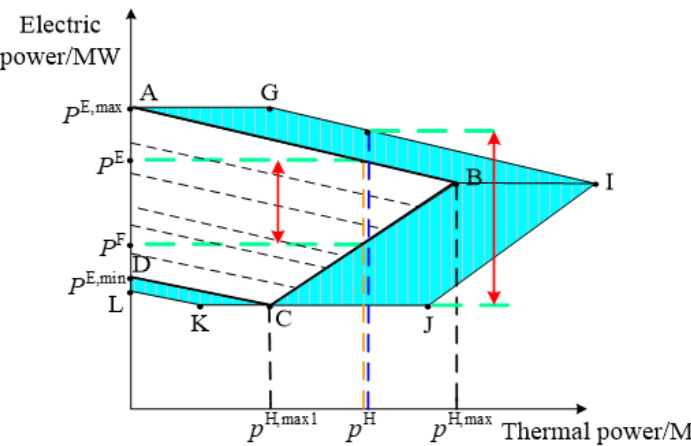
Figure 6. Electric heating characteristic curve of the unit after the addition of the heat storage device. Wind abandonment generally occurs at night, when the heat load is most